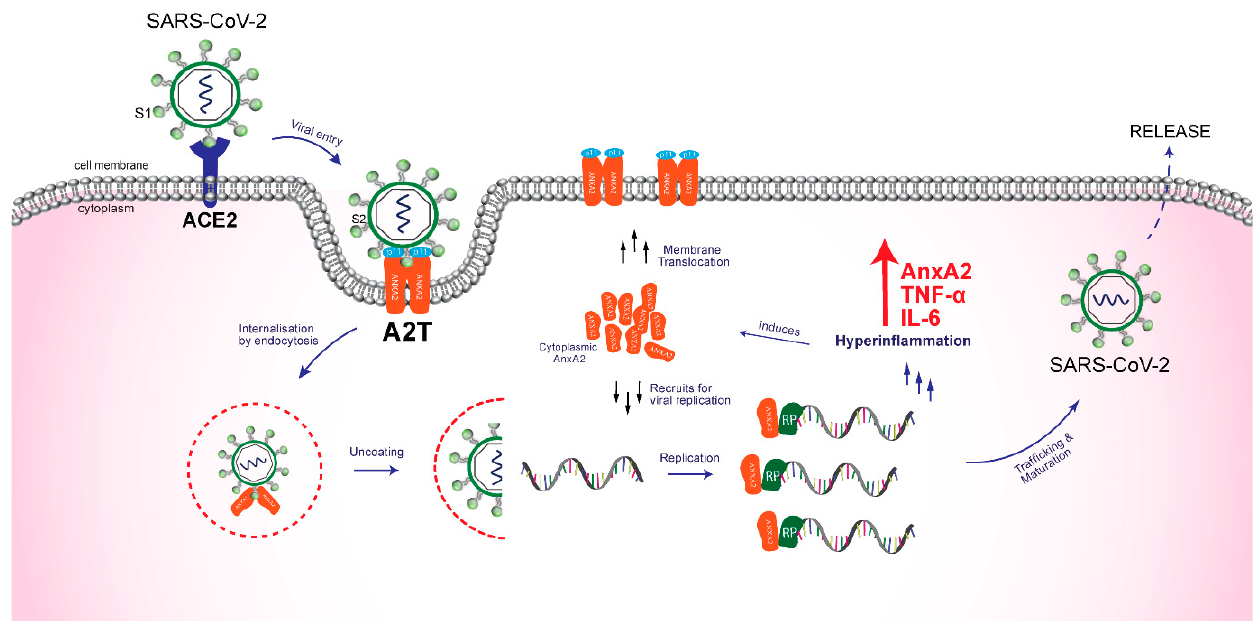
Figure 1. A schematic illustration of the possible functional role of human AnxA2 in internalization and replication of SARS-CoV-2. The process starts by the recognition of host cell ACE2 receptor by viral spike glycoprotein S1, which is followed by the spike glycoprotein S2 interaction with A2T at the membrane surface. After the furin cleavage at S1/S2 boundary, the virus gets endocytosed via clathrin/SNARE-mediated pathway. Furthermore, AnxA2 interacts with viral non-structural proteins like RNA-dependent RNA polymerase for replication and helps in trafficking, maturation, and viral release. AnxA2, being a proinflammatory upstream regulator, results in inflammatory surge and cytokine storm. ACE2, Angiotensin converting enzyme 2; AnxA2, Annexin A2; A2T, Annexin A2 Tetramer; IL-6, Interleukin 6; p11, Protein S100A10; RP, Replication protein; S1, Spike glycoprotein 1; S2, Spike glycoprotein 2, and TNF- α , Tumor necrosis factor alpha.